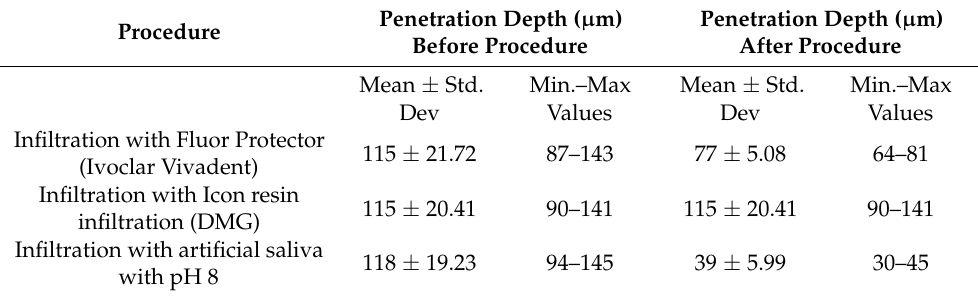
Table 2. The penetration depth of infiltration materials determined using CLSM (10 × objective in dual fluorescence mode) before and after infiltration with chemical remineralisation